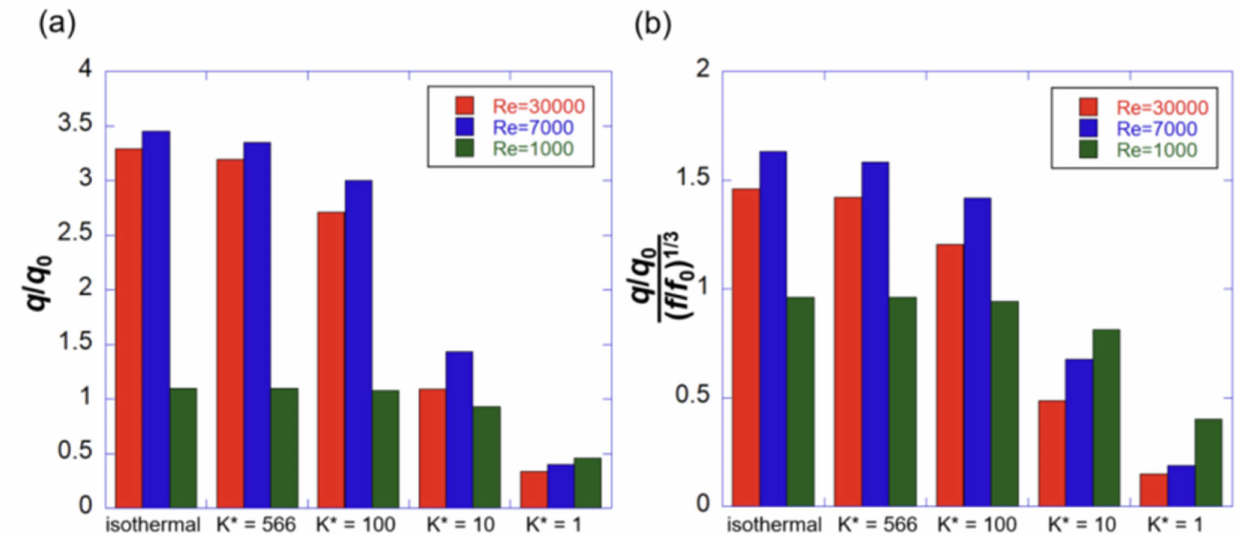
Figure 11. Heat transfer enhancement of the ribbed channel: ( a ) total heat transfer rate and ( b ) thermal